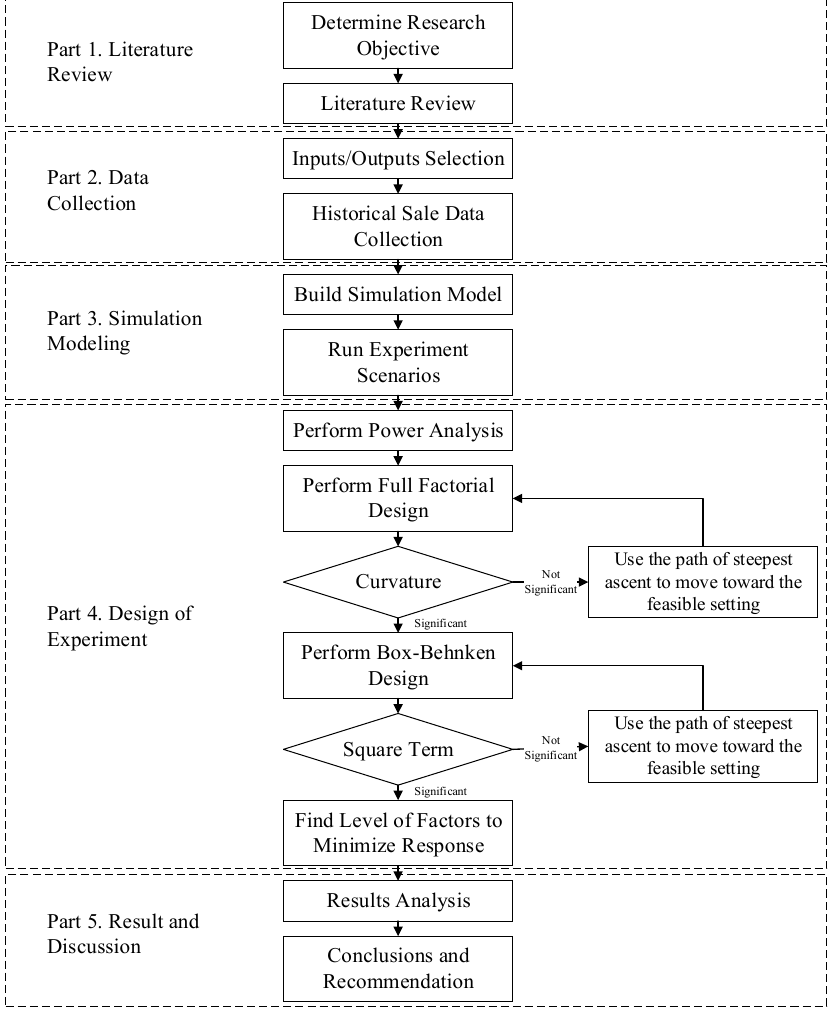
Figure 1. Procedures of research.